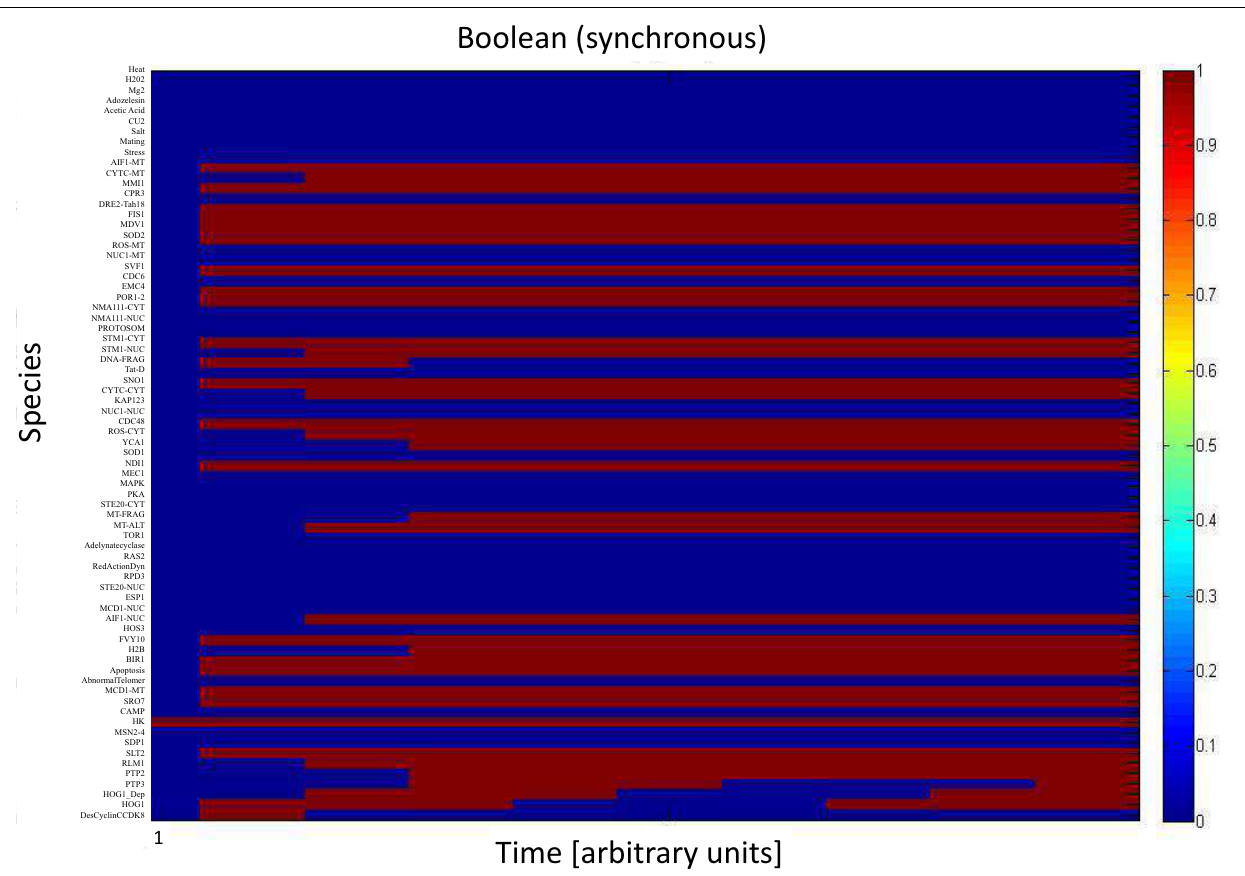
FIGURE 3 | Synchronous Boolean model. All species in apoptosis network are mapped on vertical axis. Dark blue indicates those nodes that are not activated (value = 0) while dark red refers to nodes which are totally activated (value = 1).